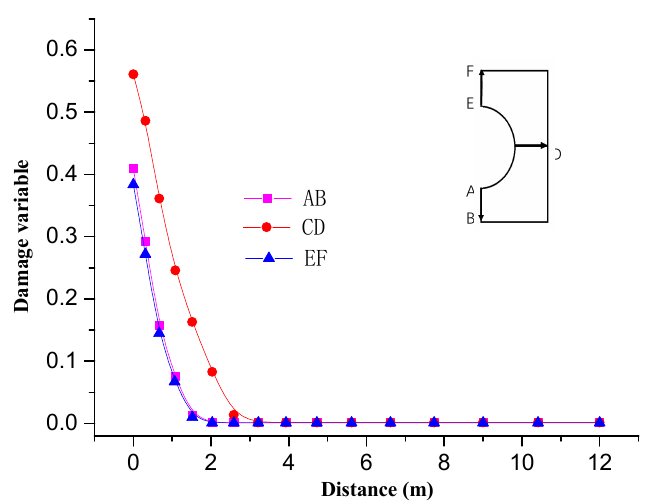
ff erent locations in the roadway.